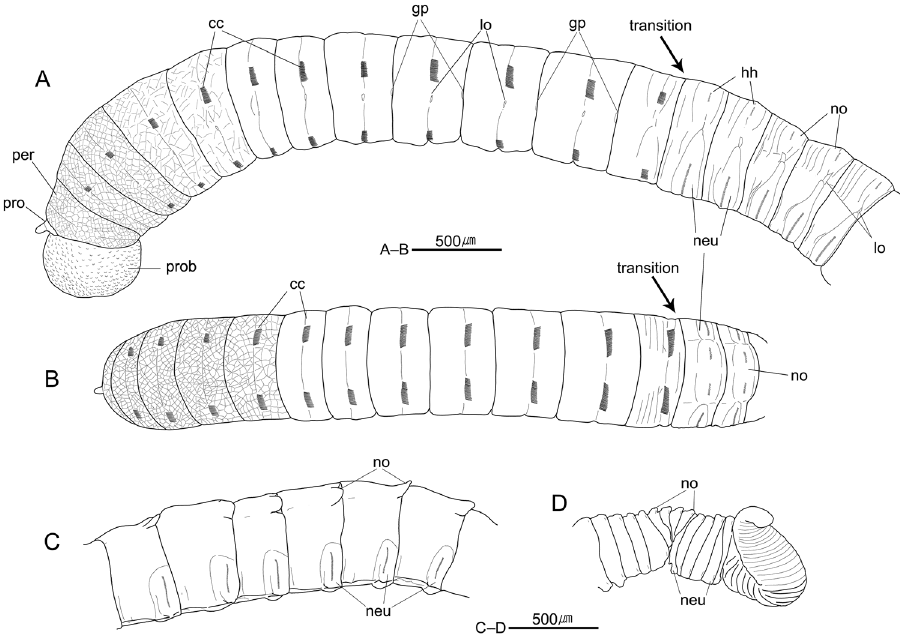
Figure 2. Notomastus koreanus sp. n. A anterior end, left lateral view (MABIKNA00146048) B same, dorsal view (MABIKNA00146048) C posterior abdominal segments, left lateral view (Holotype, MABIK- NA00066337) D posterior end, left lateral view (Holotype, MABIKNA00066337). Abbreviations: cc, cap- illary chaetae; gp, genital pore; hh, hooded hooks; lo, lateral organ; neu, neuropodium; no, notopodium; pro, prostomium; prob, proboscis; per, peristomium; transition, transition between thorax and abdomen. dial lobes in anterior to moderate abdominal region not protruded. Posteriorly extended parapodial lobes present on posterior abdominal segments. Pygidium without anal